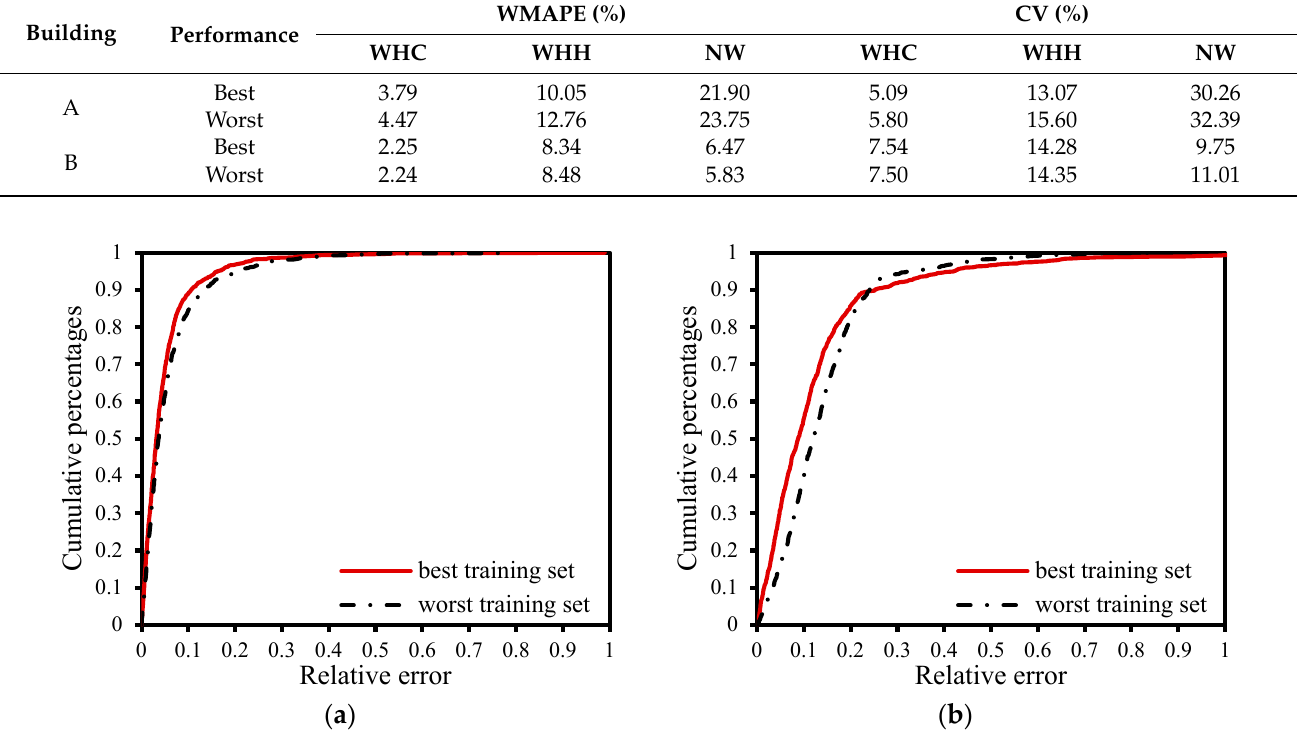
Figure 7. Building A: the probability cumulative curve of the samples at different relative error levels. ( a ) Cooling season. ( b ) Heating season.